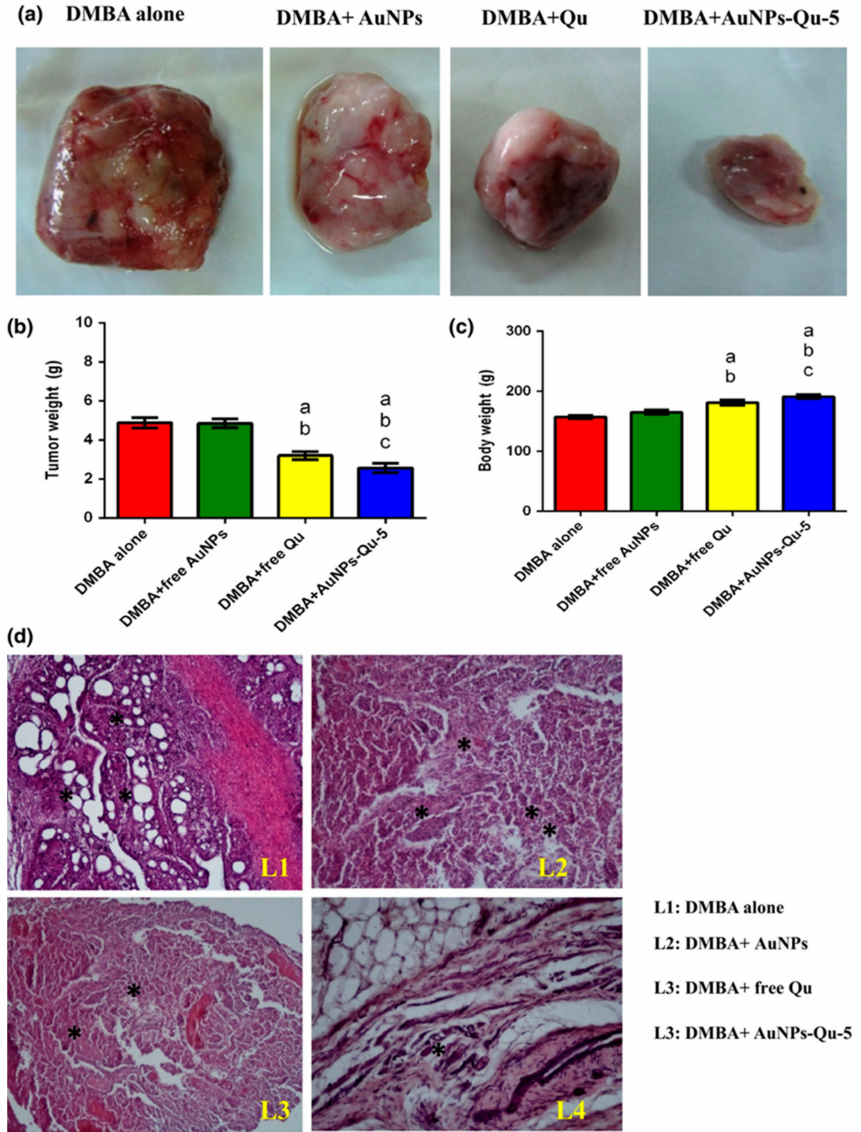
Figure 6. E ff ect of free Qu and AuNPs-Qu-5 on DMBA-induced mammary carcinoma in Sprague- Dawley rats. AuNPs-Qu-5 inhibited the DMBA-induced tumor growth in Sprague-Dawley